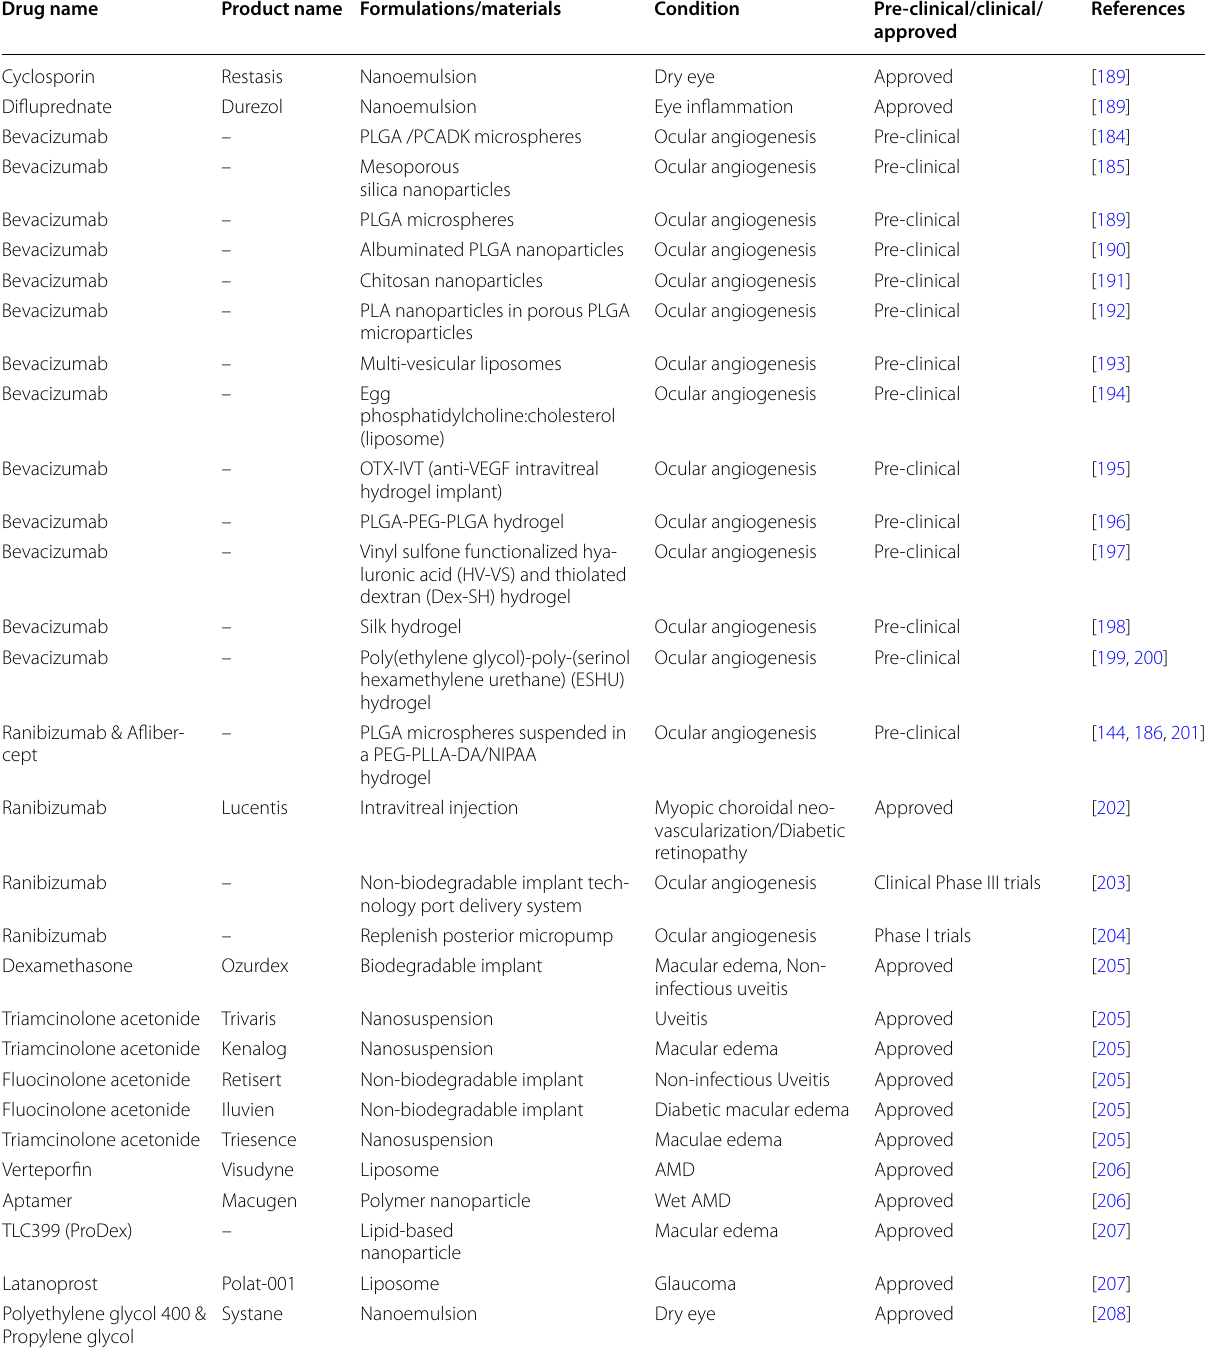
Table 4 Pre-clinical/clinical/approved formulations in ocular drug delivery